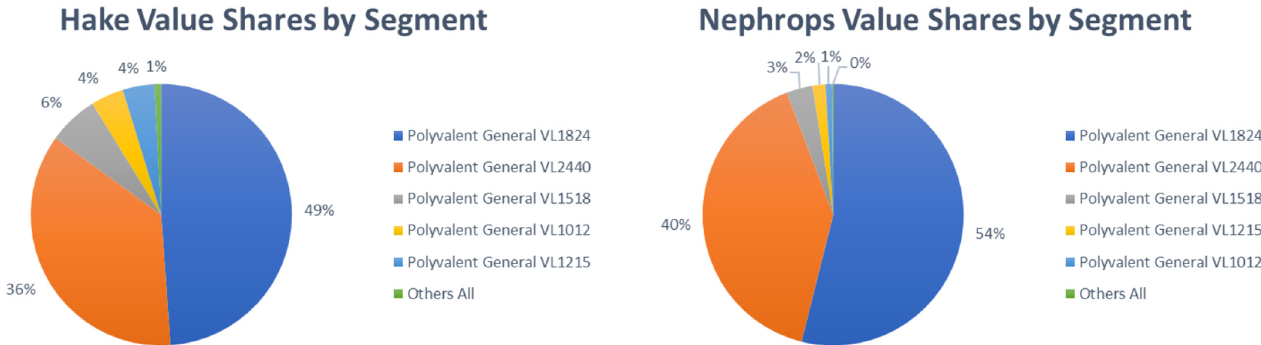
Fig. 2. Value shares of total Irish hake and nephrops landings by fl eet segment in 2019 (see Tab. A.1 in Appendix).